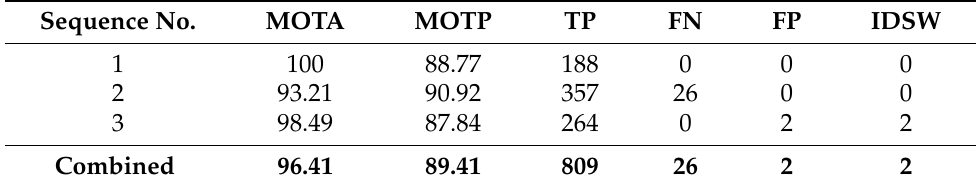
Table 8. Scenario 4—category 1 Quantitative results of the tracker’s performance to track objects of category 1 (large vessel) in scenario 3. Scenario 3 consists of three sequences involving both moving and static objects, dynamic movement of the camera’s viewpoint are applied.